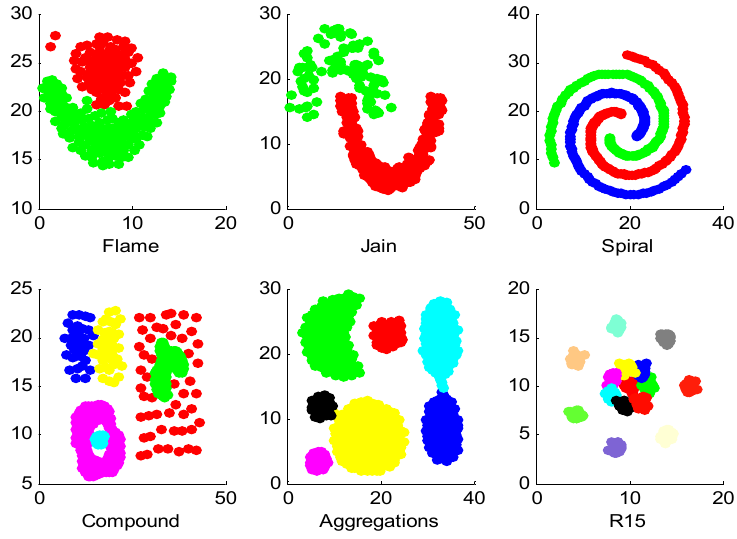
Figure 1. Synthetic